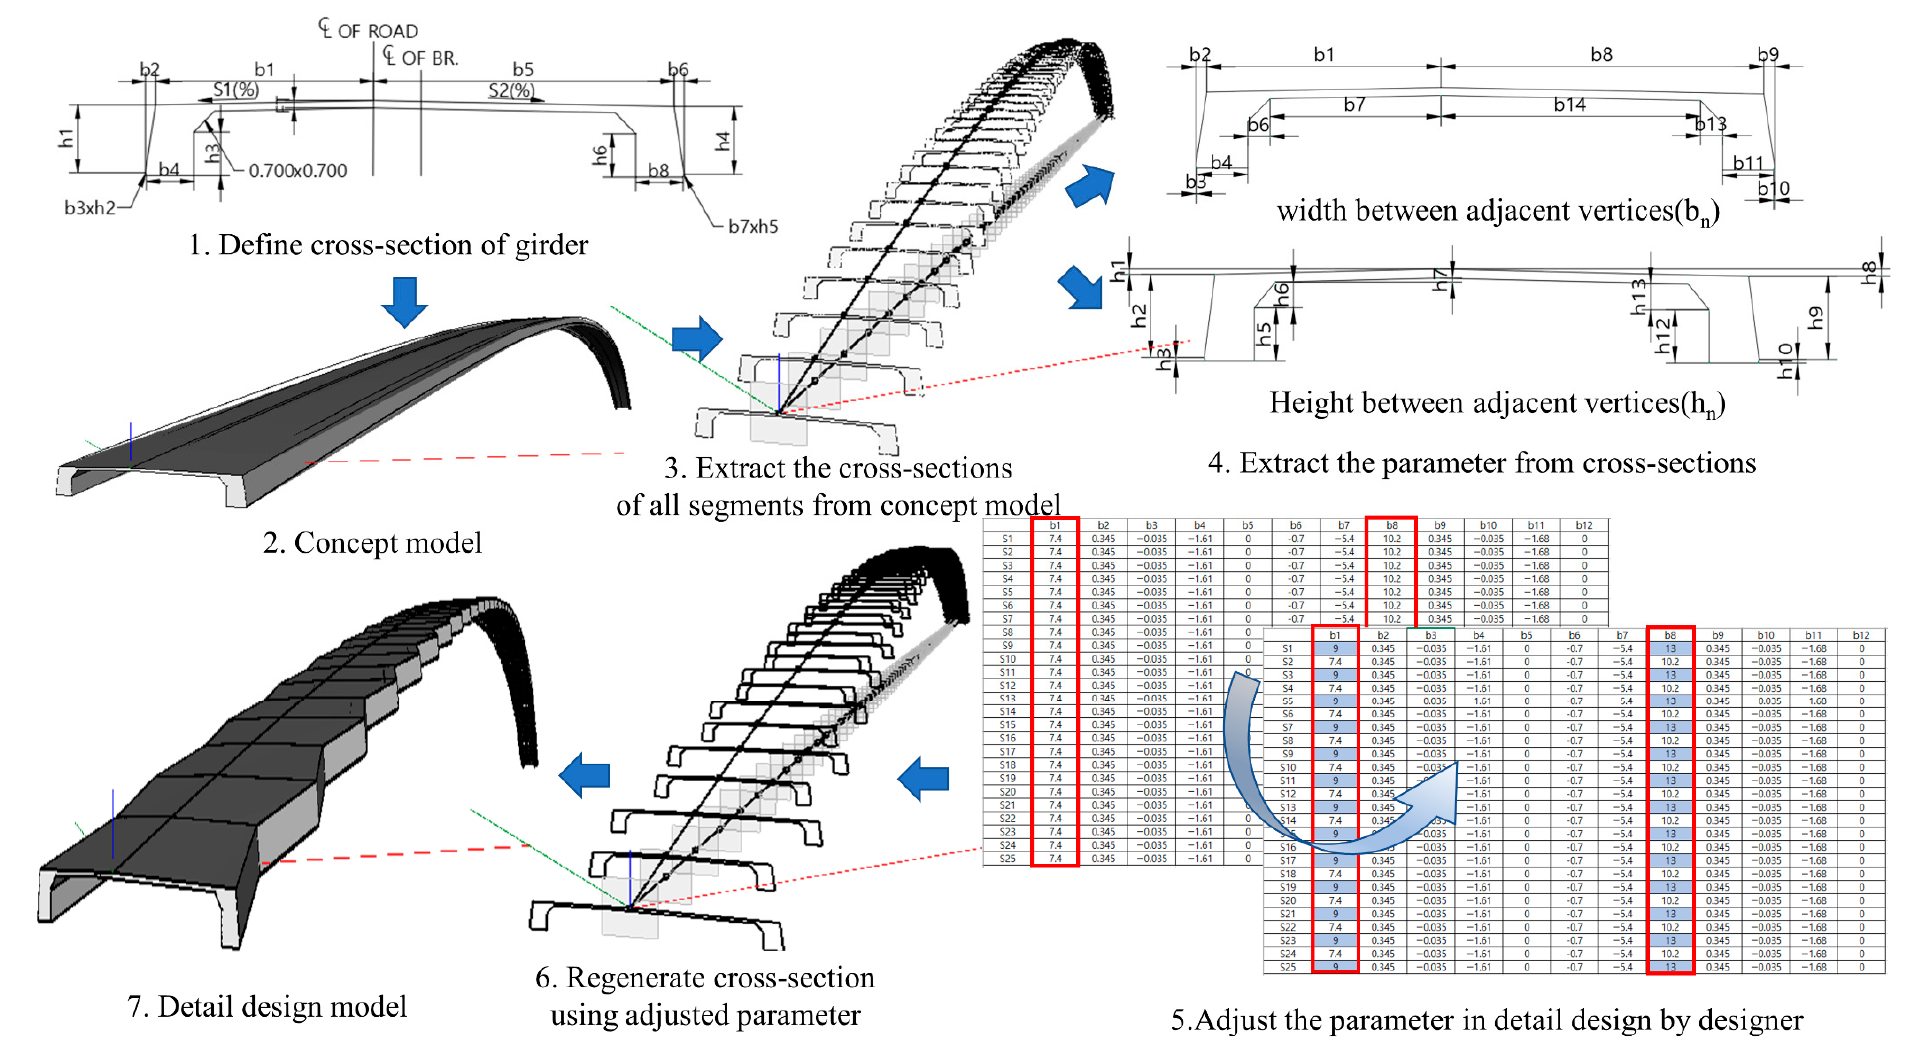
Figure 9. Model authoring of stiffening girders using the design parameter datasets.